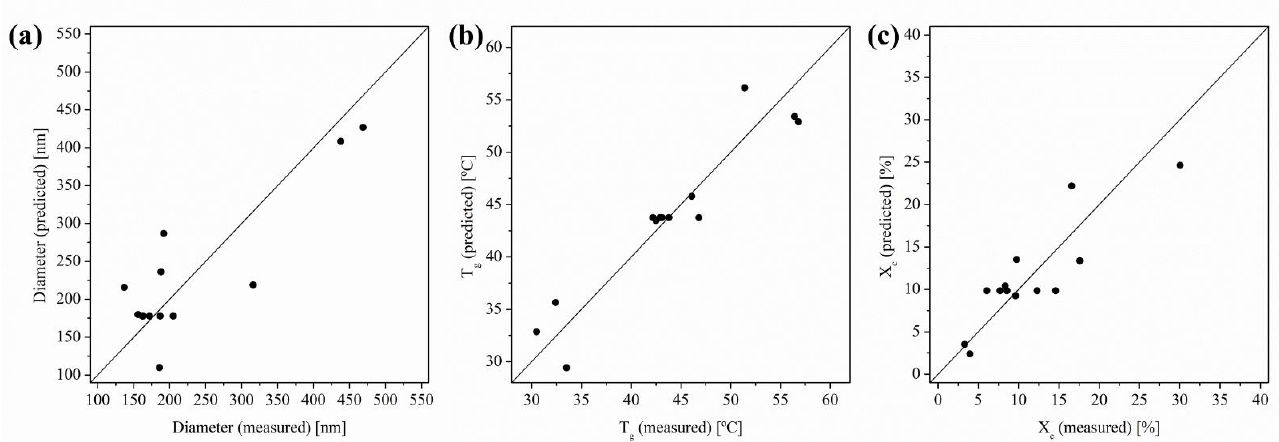
Figure 3. Predicted versus measured values for ( a ) diameter, ( b ) glass transition temperature and ( c ) degree of crystallinity.